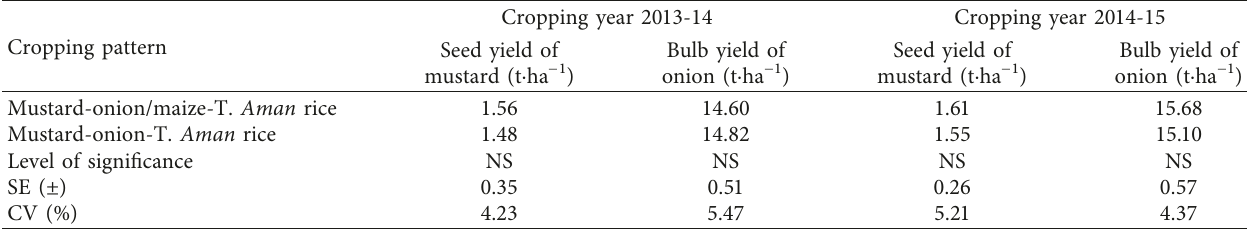
Table 2: Productivity of component crops (mustard and onion) in different cropping patterns. Cropping pattern